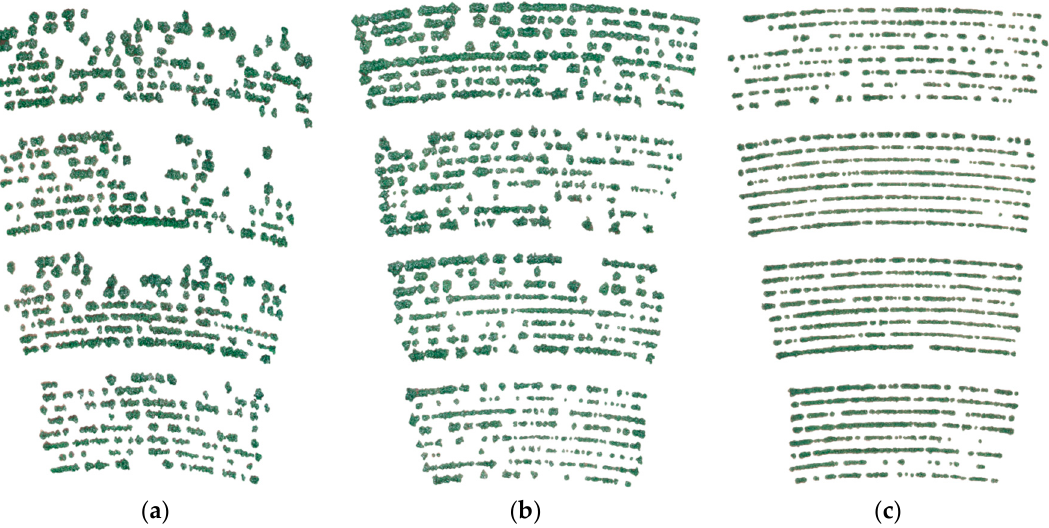
Figure 3. Results of the application of the binary large object (BLOB) algorithm to the orthomap red, green, and blue (RGB) images of the three plots. A total of 1133 BLOBs were defined in the three plots. The number of BLOBs varied among the plots, with a total of ( a ) 317 BLOBs in plot 1, ( b ) 391 BLOBs in plot 2 and ( c ) 425 BLOBs in plot 3. Table 2. Summary statistics of binary large objects (BLOBs) for three plantings. Plot